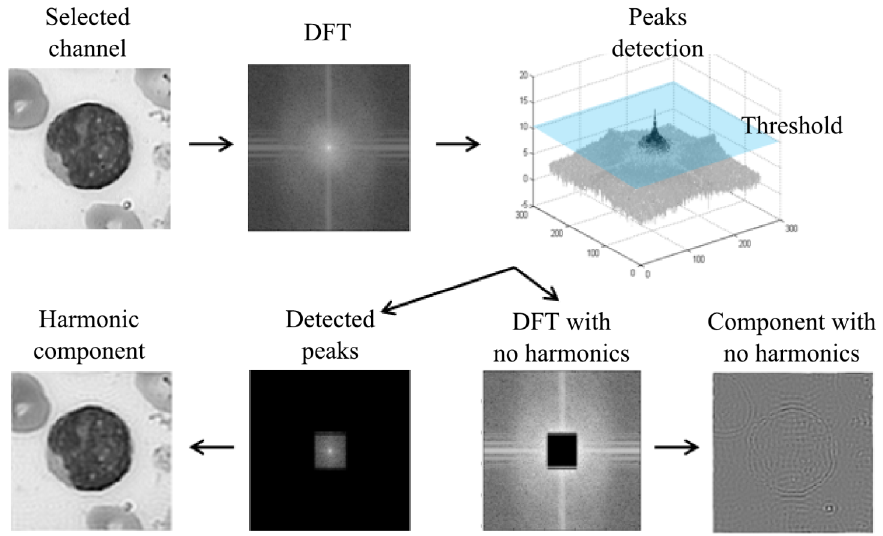
Fig 5. Harmonic field parameterization.